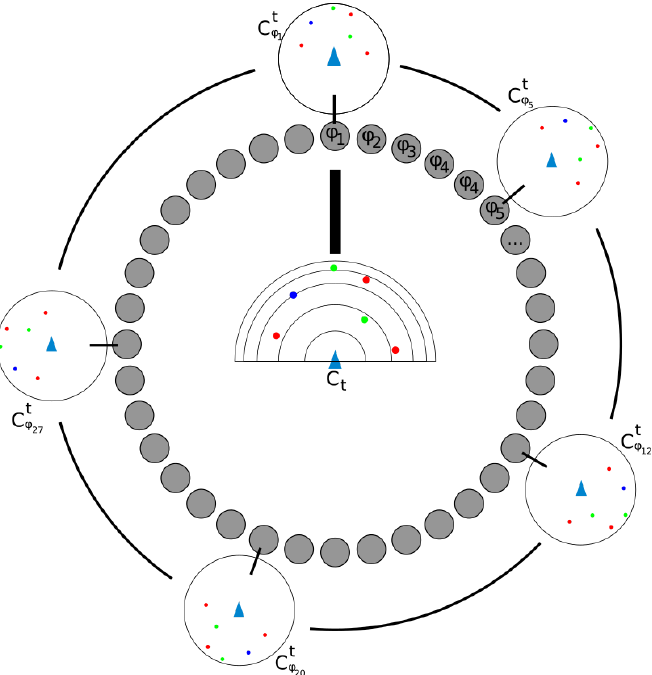
Figure 5. Head direction cells cover the [ 0;2 π [ interval uniformly. The head direction cells use the current context observed by the agent as input and rotates this context by their attributed angle. Each head direction cell thus simulates a different rotation of the agent from its current orientation. These rotated contexts are then used in combination with contexts produced by grid cells to estimate the orientation of the agent (see Section 4.4 and Equation